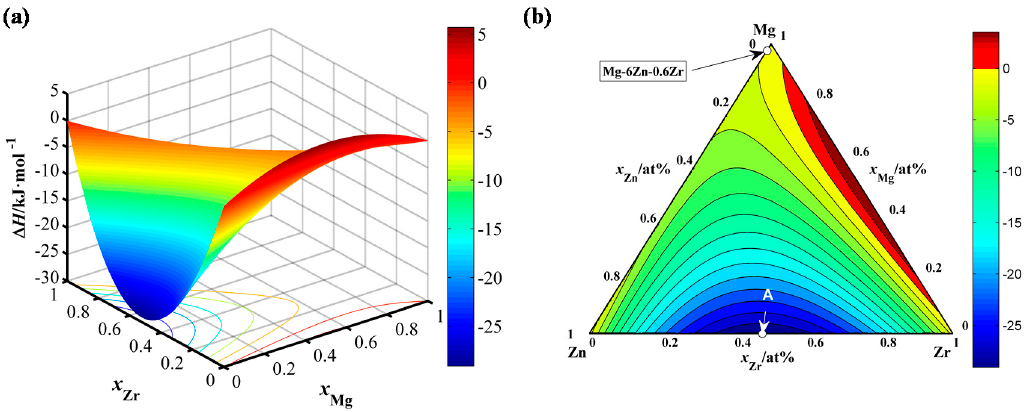
Figure 5. Three-dimensional diagram ( a ) and isogram ( b ) of the mixing enthalpy of liquid Mg-Zn-Zr alloys.